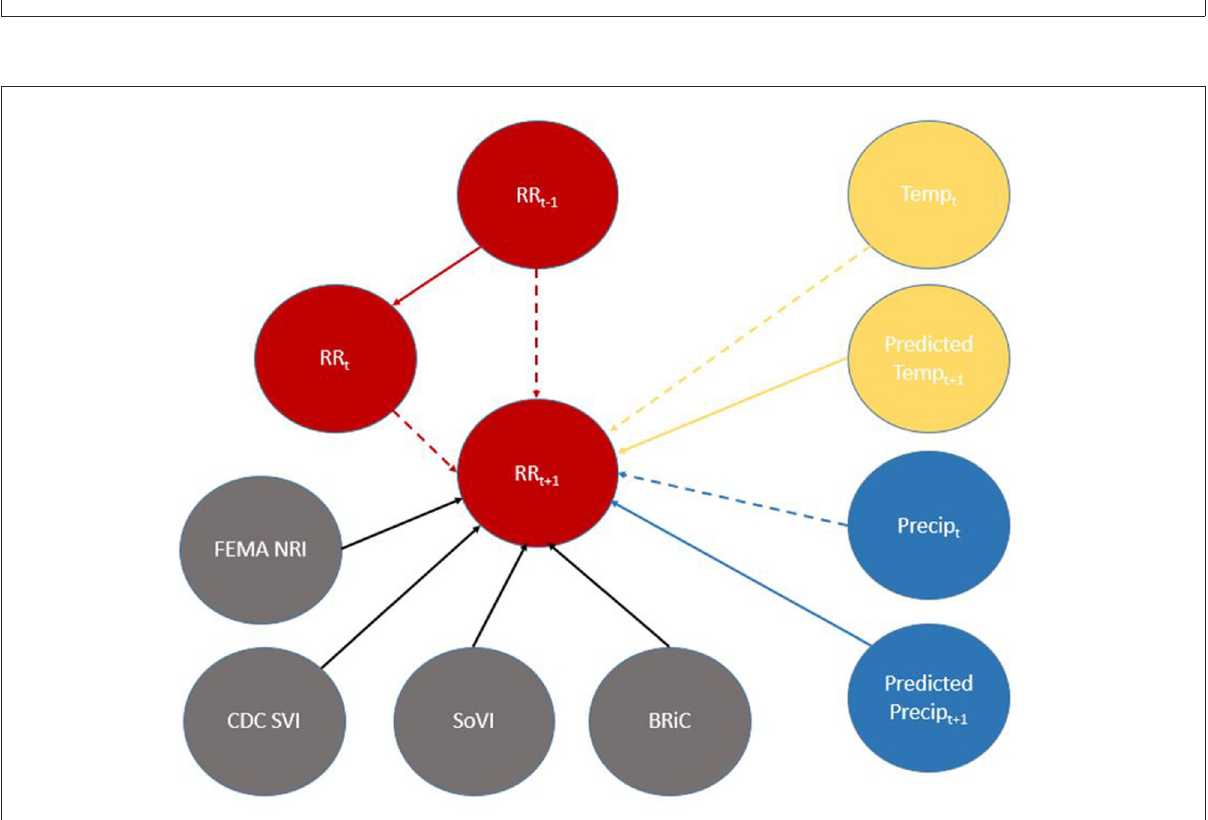
FIGURE6 Directed Acyclic Graph (DAG) for (time-slice t) from DBN for predicting relative risk of COVID-19 infection. Dashed lines represent data input from a non-contemporaneous node/inter-time-slice